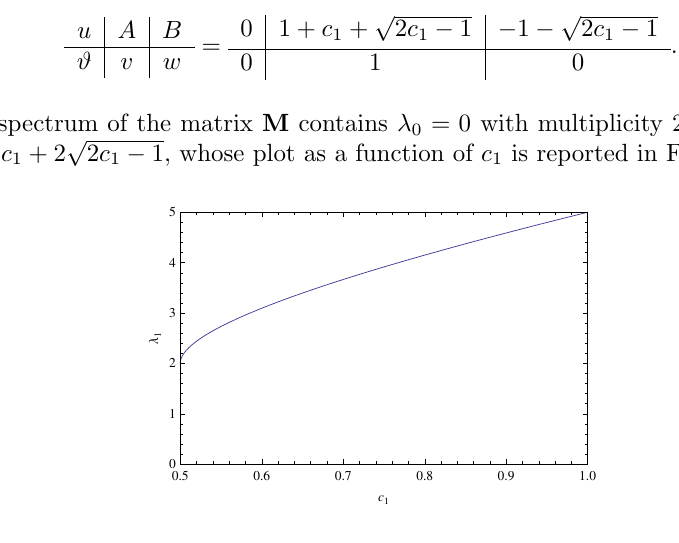
Figure 1. Plot of the eigenvalue λ 1 of the matrix M for algebraically stable TSRK methods (4.4) with p = q = s =